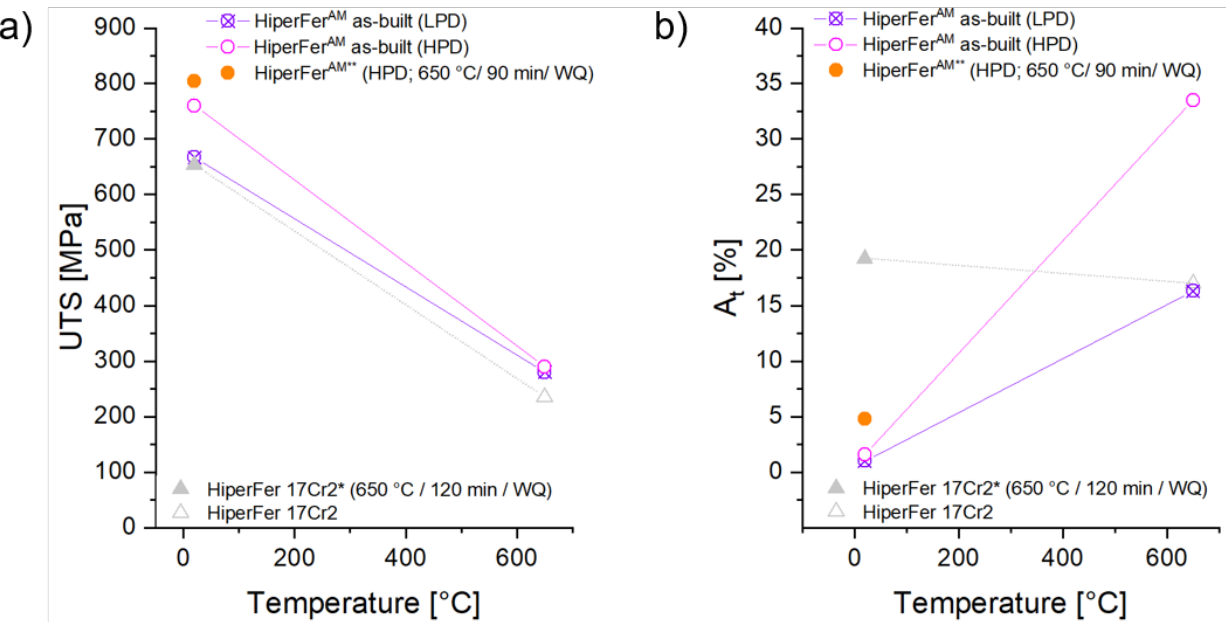
Figure 11. ( a ) UTS and ( b ) rupture elongation (A t ) of the 17Cr2 and HiperFer AM variants (LPD and HPD) at 20 °C and 650 ° C . HT: * 650 °C/120 min, ** 650 °C/90 min.